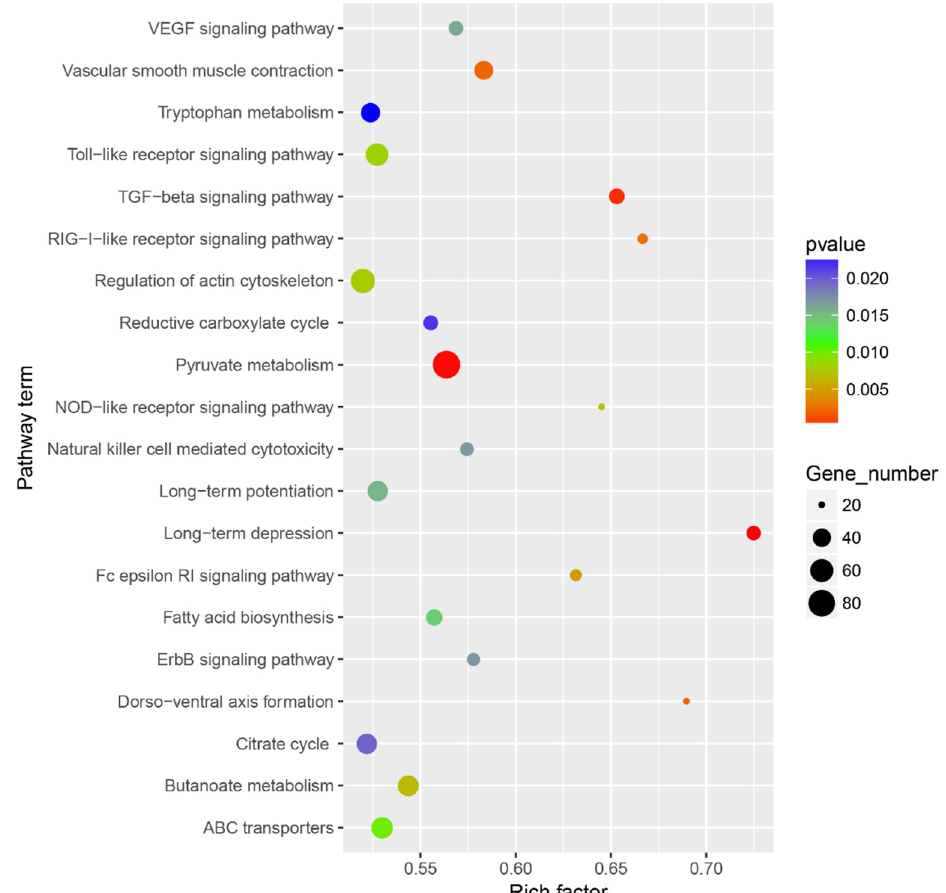
Figure 7. Analyses of significant KEGG enrichment scatterplot distribution map based on miRNA targets.